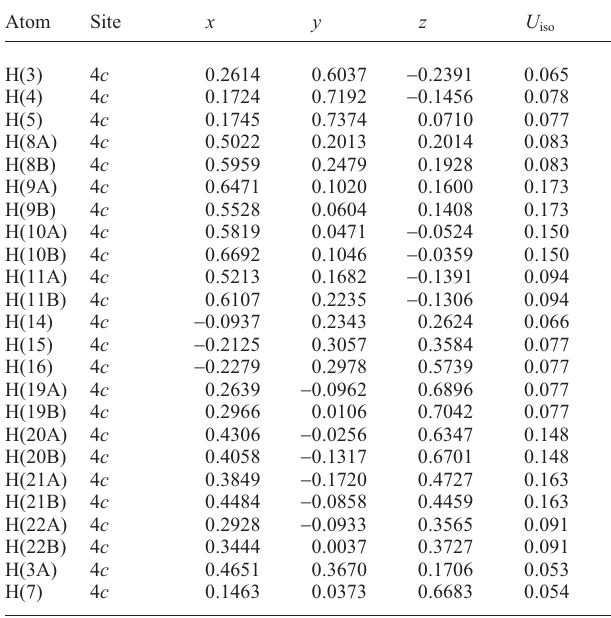
Table 1. Data collection and handling.